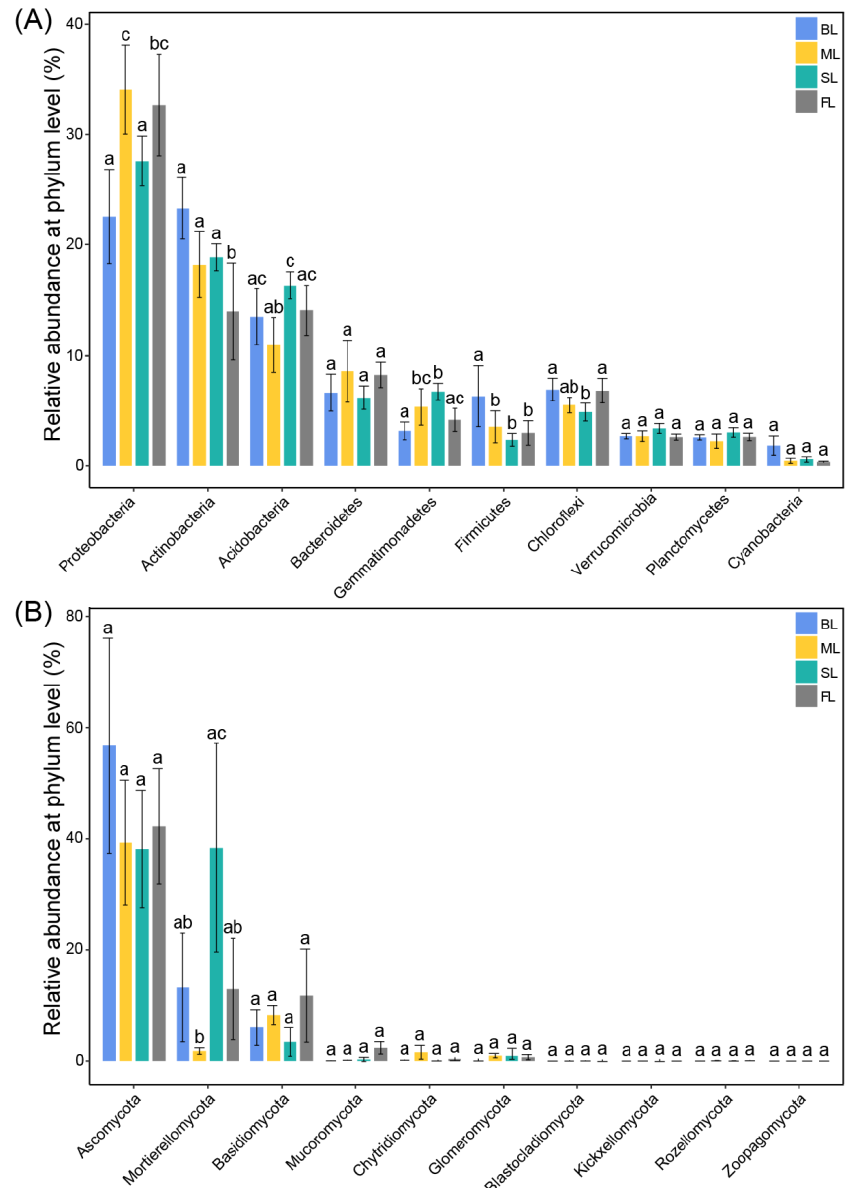
Figure 4. Relative abundance of the dominant bacteria ( A ) and fungi ( B ) in different land-use types. Error bars represent standard error ( n = 4). Different letters above the bars indicate significant differences among different land-use types ( p < 0.05) based on one-way ANOVA with the LSD test. Abbreviations: FL, forest land; SL, sugarcane land; ML, maize land; BL, barren land.